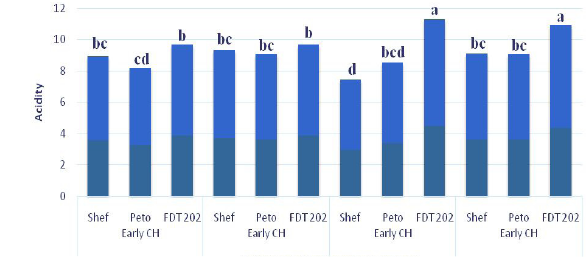
Fig. 2. Interaction between plant spacing × cultivar on